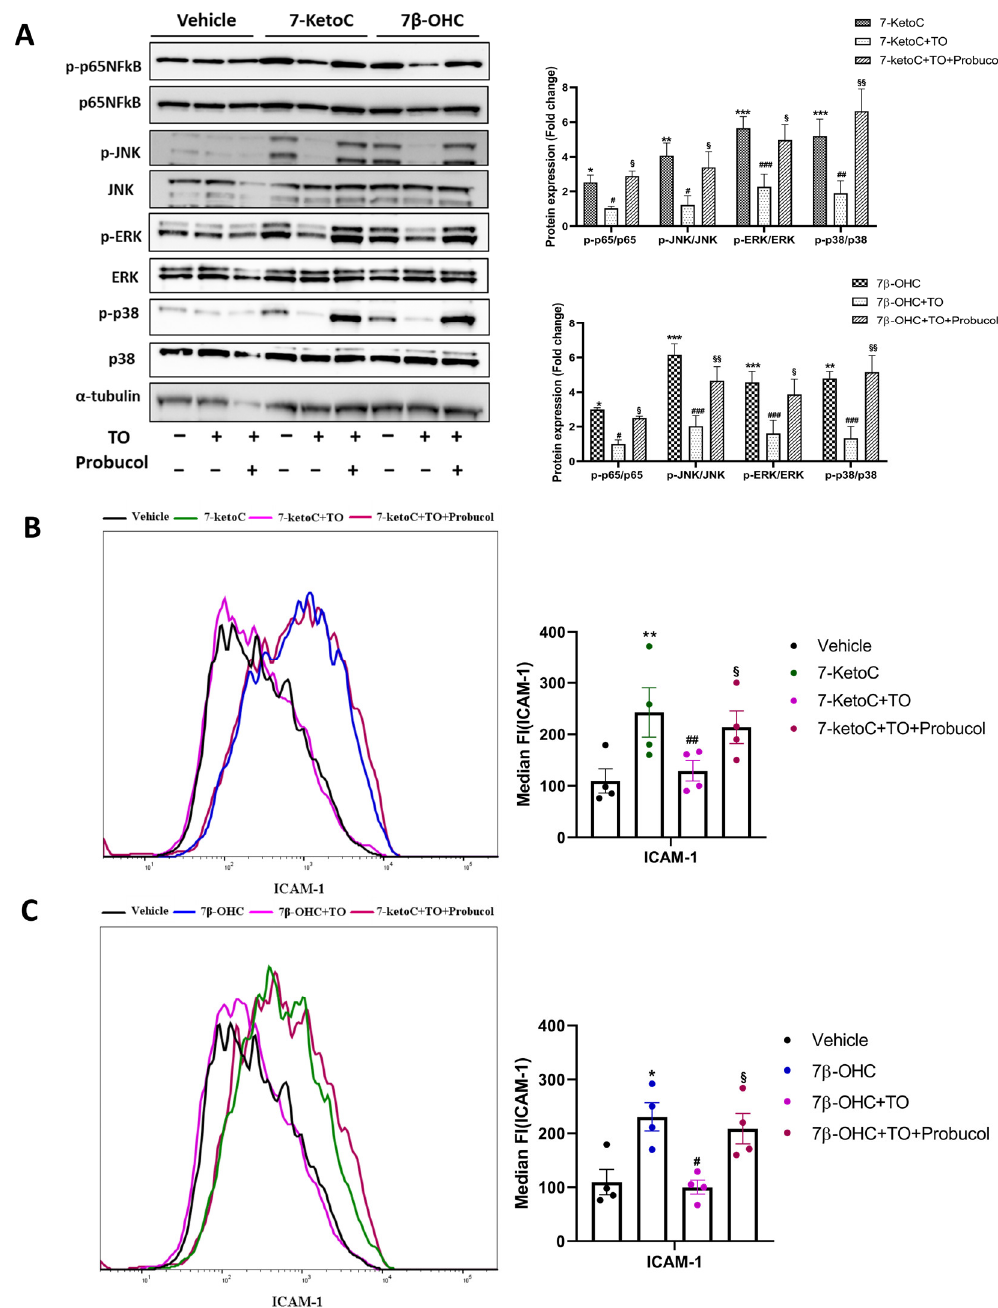
Figure 5. Probucol antagonized the protective effects of TO against oxysterols. ( A ) Representative immunoblot and densitometric analysis after probucol treatment showing MAPK and NF κ B signaling re-activation in fpEC ( n = 4), as created in oxysterol-treated cells. Expression of all targets in vehicle control is normalized to one (not shown in the graph), and target protein expression in treatment groups demonstrated are relative to the vehicle. ( B , C ) Cell surface expression of ICAM-1 shows the same pattern in cells treated with probucol ( n = 4). Data are presented as mean ± SEM. Statistically significant differences between vehicle and oxysterol treatment (indicated with *), between oxysterol and oxysterol + TO treatment (indicated with #), and between oxysterol + TO and oxysterol + TO + probucol (indicated with §), were calculated using two-way ANOVA for phospho-proteins) and one-way ANOVA (for ICAM-1), followed by Tukey’s post hoc test. §/#/* p < 0.05, §§/##/** p < 0.01 and ###/*** p < 0.001.